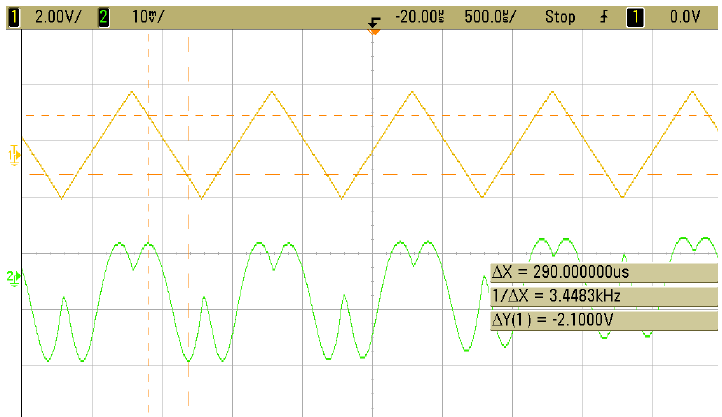
Figure 5. V π measurement of the EO-waveguide from a MZI configuration showing a V π of 2.1 V. The top (yellow) wave form is the applied triangle wave, and the bottom (green) waveform is the optical modulation response.